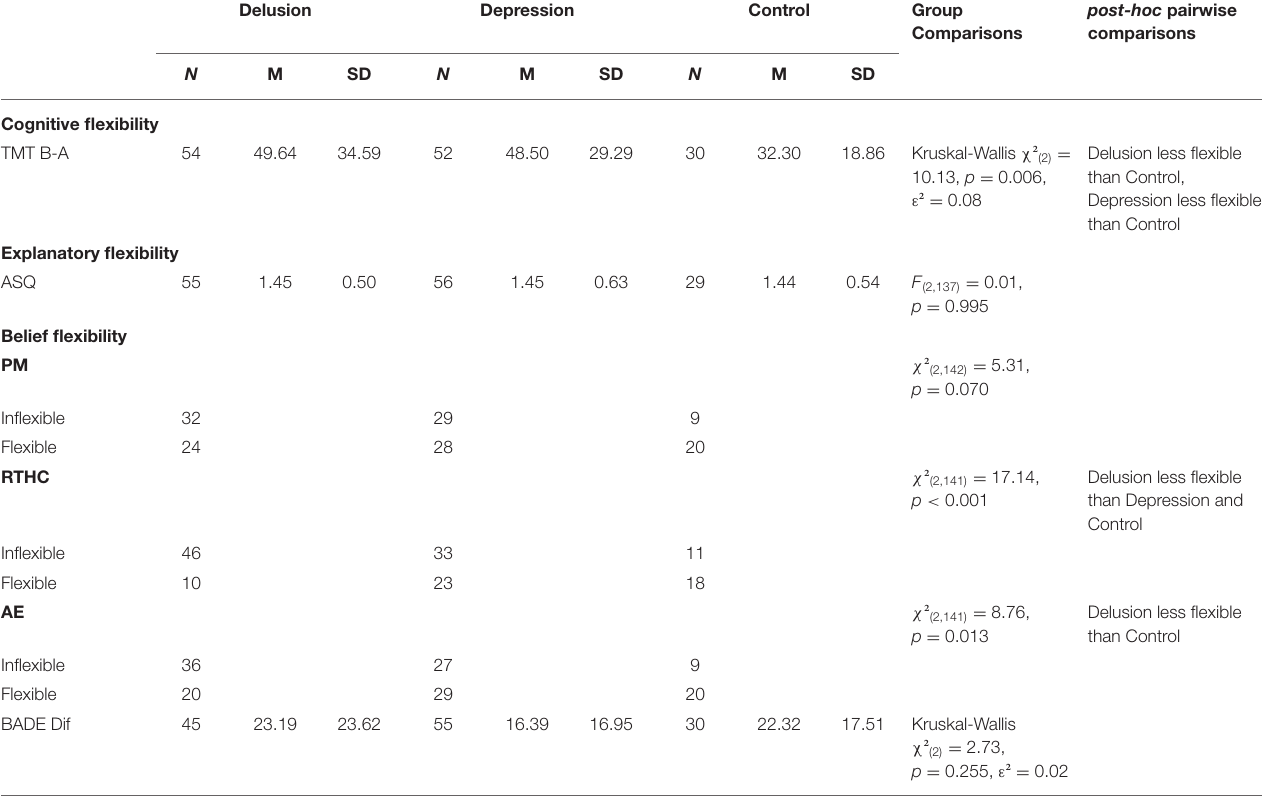
TABLE 3 | Means and SDs of flexibility indices.